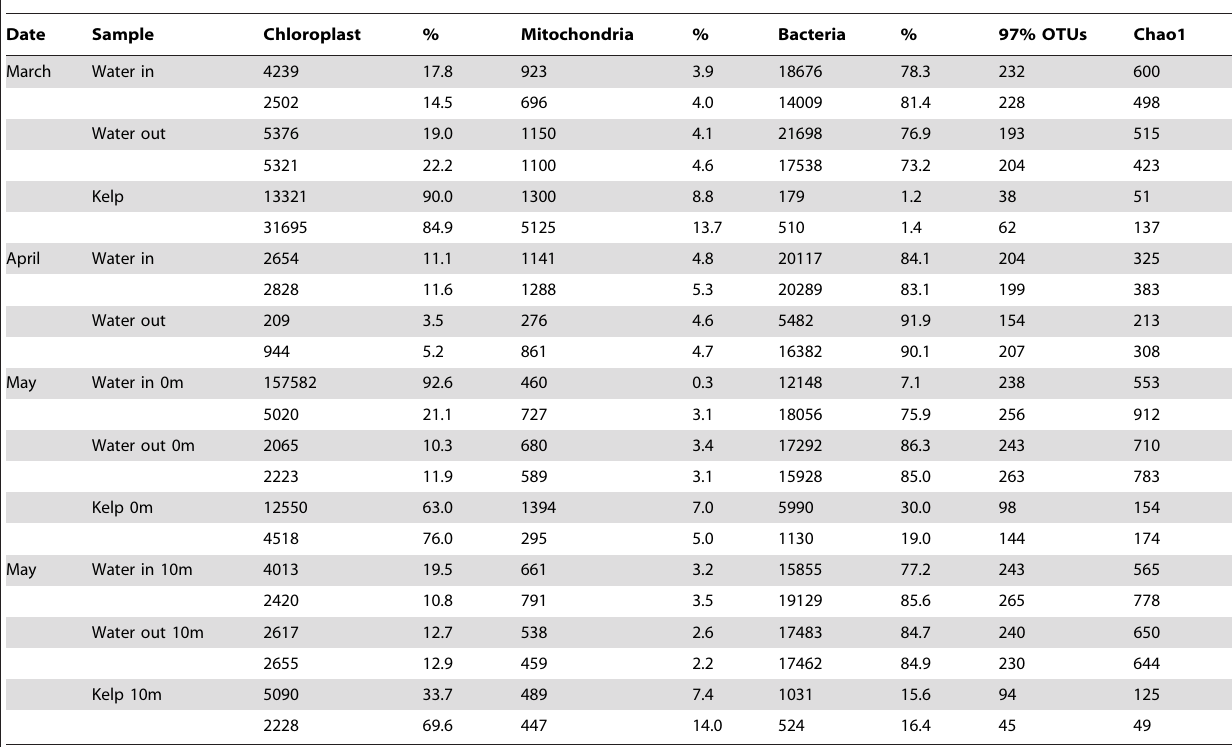
Table 1. Summary of the sequencing